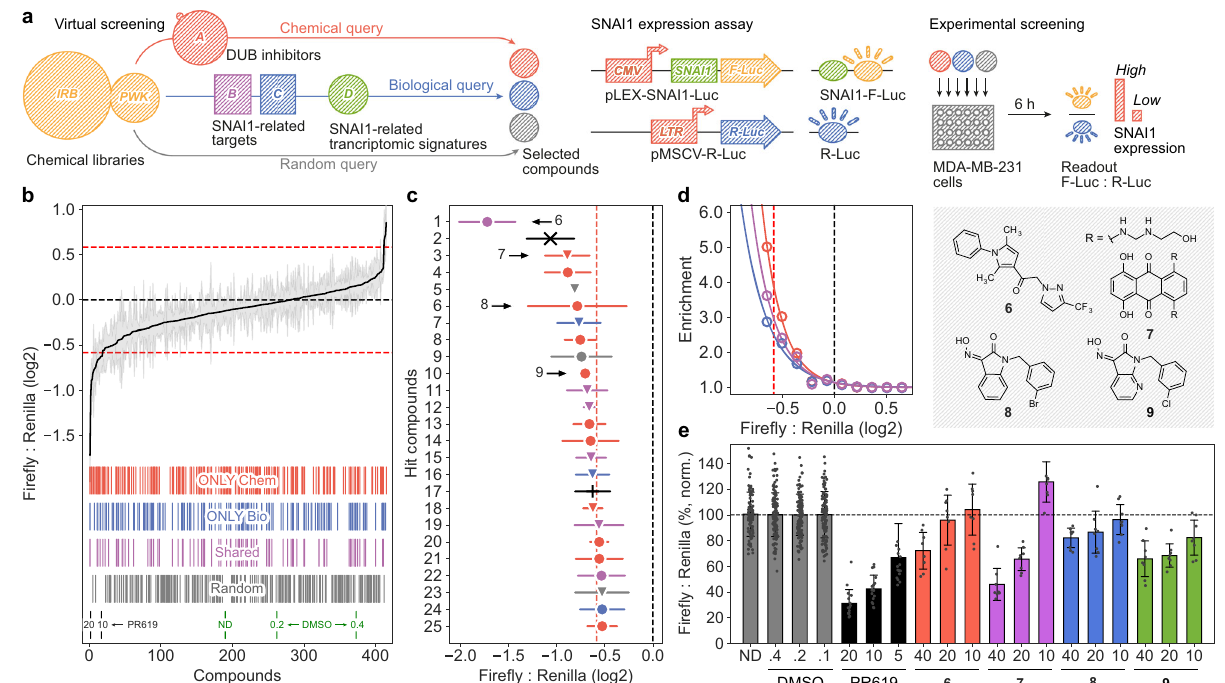
Fig. 4 Library enrichment to identify Snail1 inhibitors. a Scheme of the methodology. Two compound libraries are screened (IRB and PWCK). A chemical query is done by looking for similarities with known DUB inhibitors. A biological query is done by looking for transcriptional (D1) and network-based (C3 – 5) signature matchings with Snail1-relevant targets. Random molecules are selected to estimate the background hit-rate. A Snail1 expression assay based on Fire fl y:Renilla luciferase ratios are used to screen candidate compounds. b Library enrichment quanti fi cation showing the effects of compounds selected by chemical (red), biological (blue), shared between both (magenta), and random (gray) queries, as well as the positive (PR-619) and negative (DMSO) controls. c Detail of the top 25 hit compounds. d Fold enrichment of compounds selected by chemical (red), biological (blue), and shared (magenta) queries with respect to random picks, based on their capacity to modulate Snail1 levels (Fire fl y:Renilla assay). Median± MAD ( n = 4). e MDA-MB-231 cells stably expressing luciferase constructs were treated for 6 h with the indicated compounds, at different doses. Fire fl y:Renilla ratios were normalized with the corresponding concentration of vehicle (DMSO). Mean ± SD of 2 independent experiments, each of them including 4 replicas, are